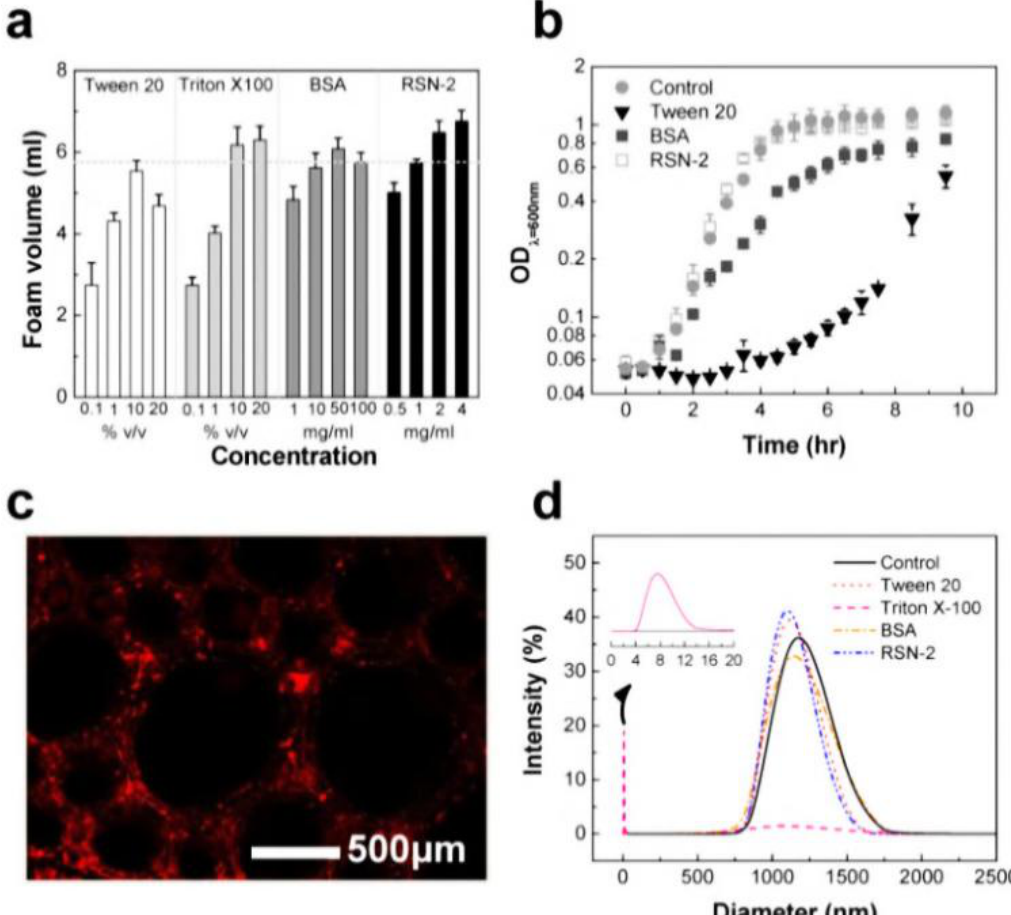
Figure 12. ( a ) The foamability of Tween 20, Triton X-100, BSA, and RSN2